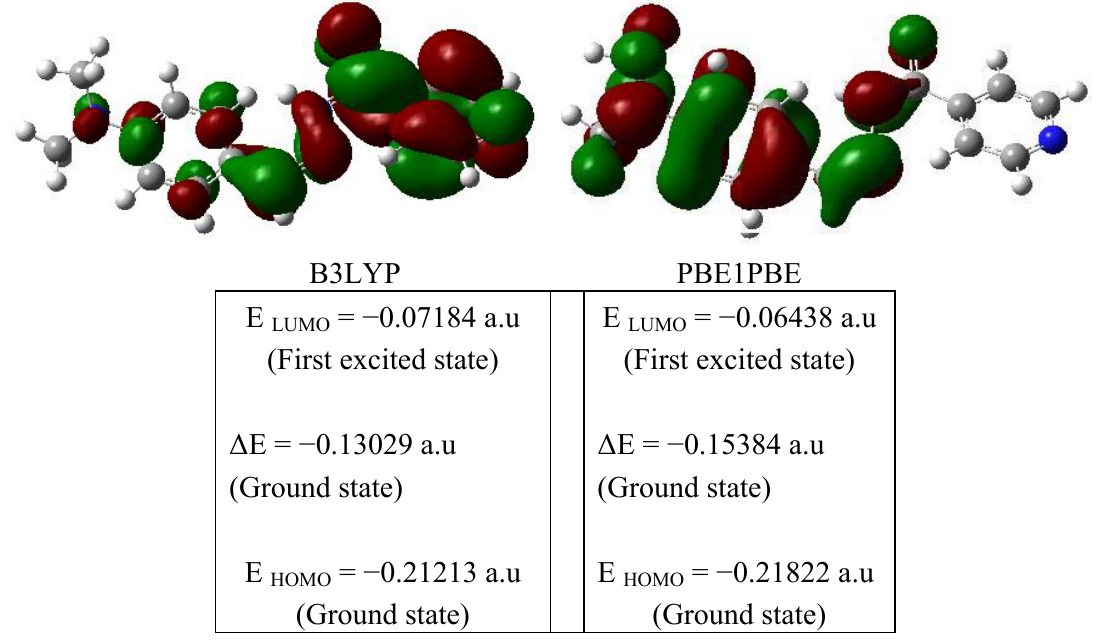
Figure 4. The atomic orbital compositions of the frontier molecular orbital for compound (1).